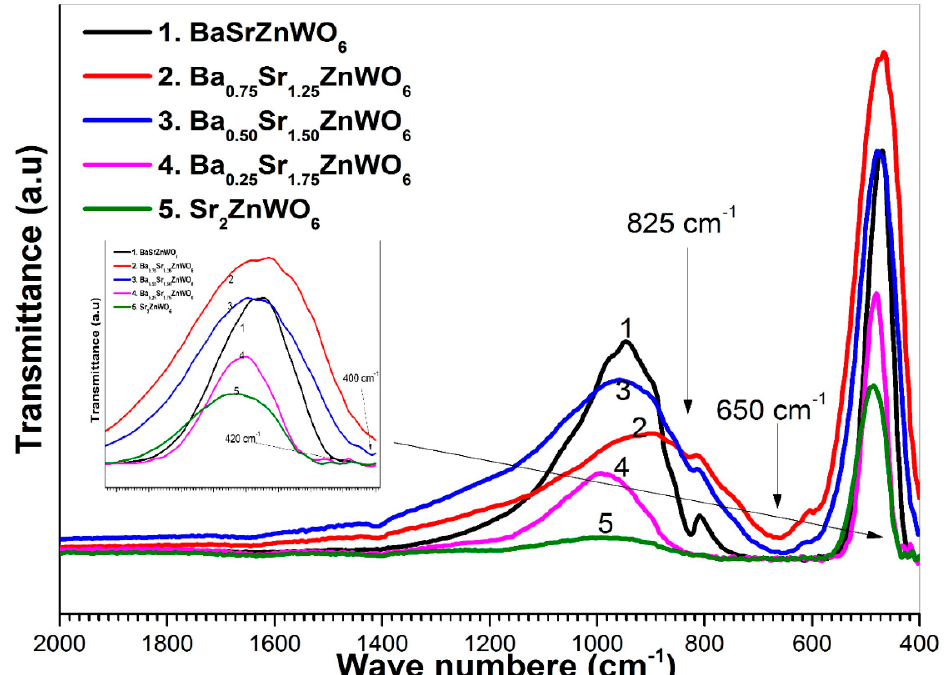
Figure 6. FTIR transmittance spectra of the Ba 2 − x Sr x ZnWO 6 (x = 1, 1.25, 1.50, 1.75, 2) double perovskite series.